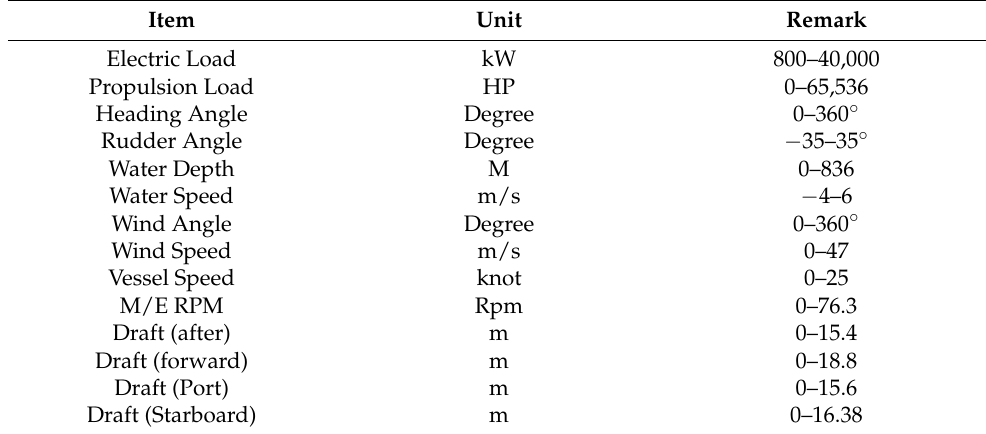
Table 1. List of selected data.